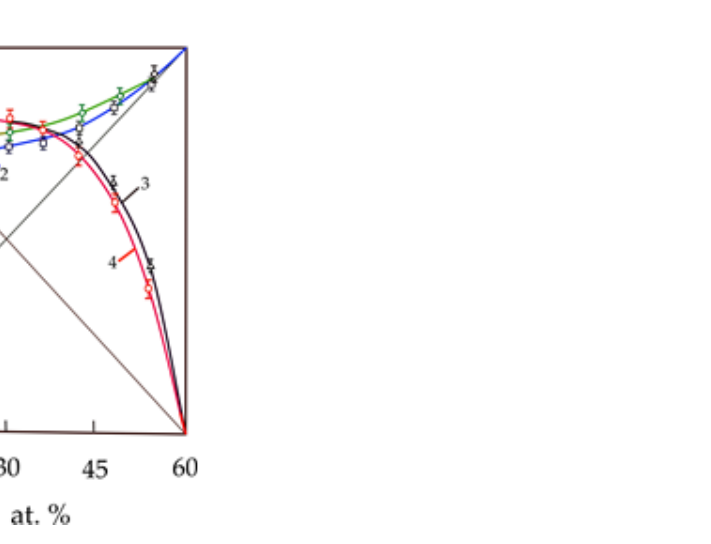
Figure 4. Activity of constituents in the Al-Al 2 Te 3 system (1, 2-activity of aluminum telluride; 3, 4-aluminum at temperature, K: 1, 3-1233; 2, 4-1353.). Table 4. Changes in partial and integral mixing entropies of the Al-Te system. Composition of the Alloy,